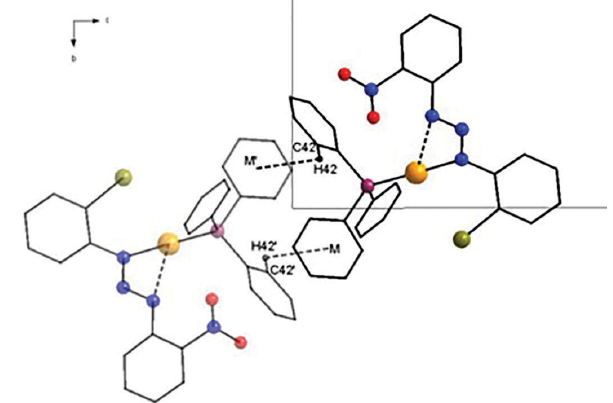
FIGURE 4 - Projection of the centrosymmetric dimers of the complex, in the crystallographic direction of the α axis, formed by non-classical aromatic hydrogen bonds C-H ∙∙∙ M (where M is the centroid point of the aromatic ring C51'-C56 '). Hydrogen atoms are omitted for better viewing. Showing partial cell content. [Symmetry Code ('): x-1, y-2, z]. [Código de simetria (’): 1-x, 2-y, -z].